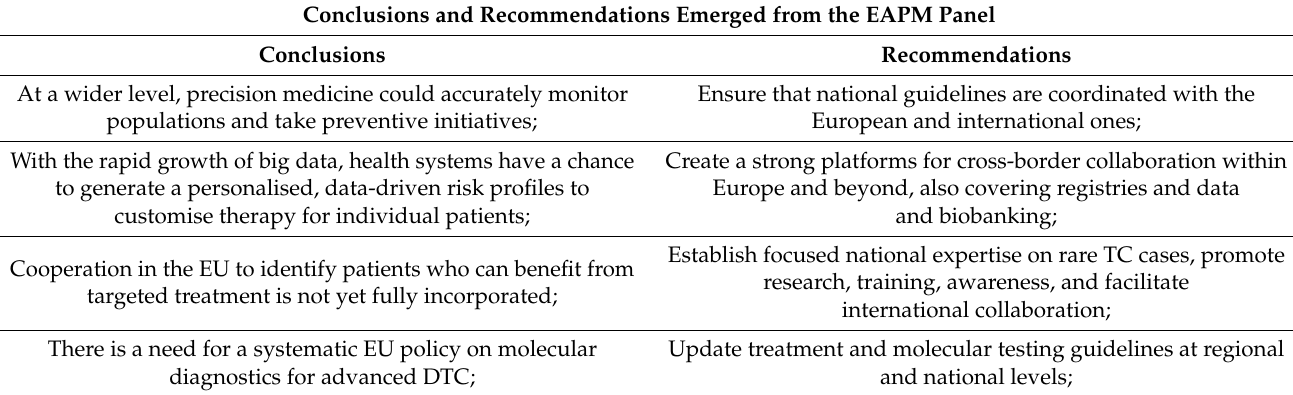
Table 3. Summarised conclusions and recommendations regarding tackling TC across